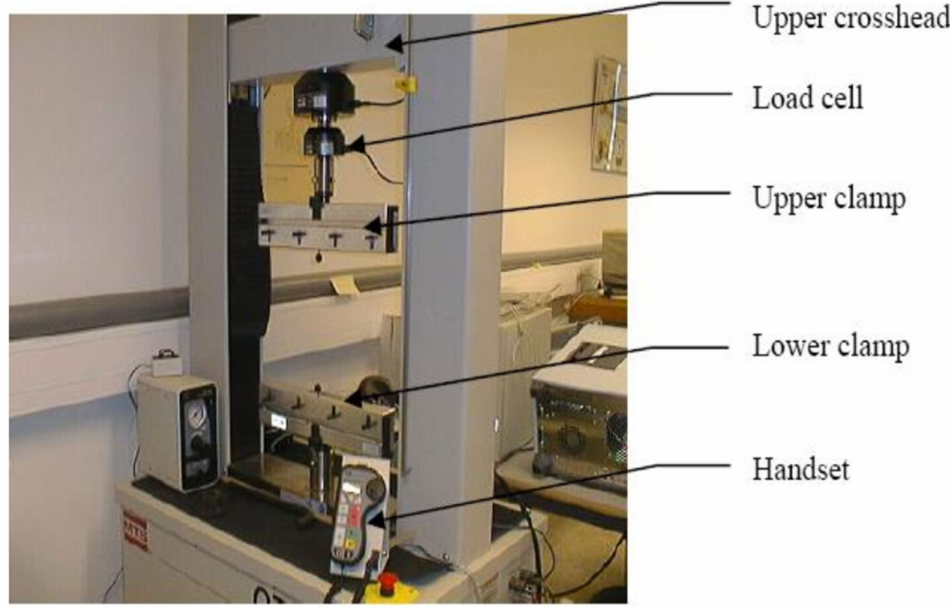
Figure 3. MTS machine at BTH